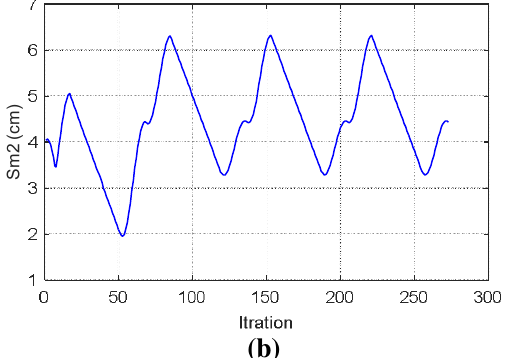
Fig. 13. Showing (a) Leg 2 in swinging phase. (b) The stability margin (cm) when leg2 is swing. vw C